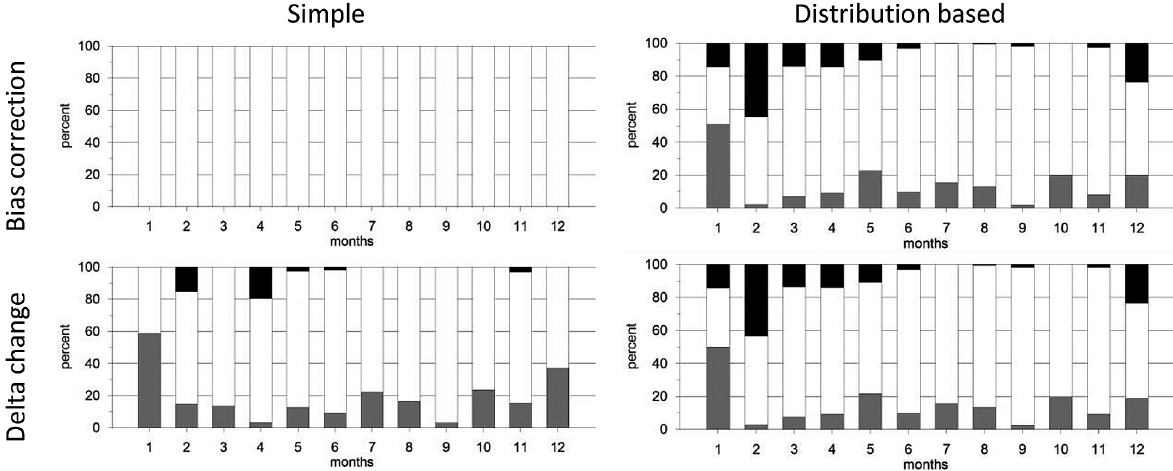
Fig. 3. Frequencies of improvements (grey), no change (white) and worsening (black) after corrections made by different methods for a standard deviation. Bias correction methods in the upper raw and delta change methods in the lower raw, simple variants in the left column and distribution based variants in the right column.